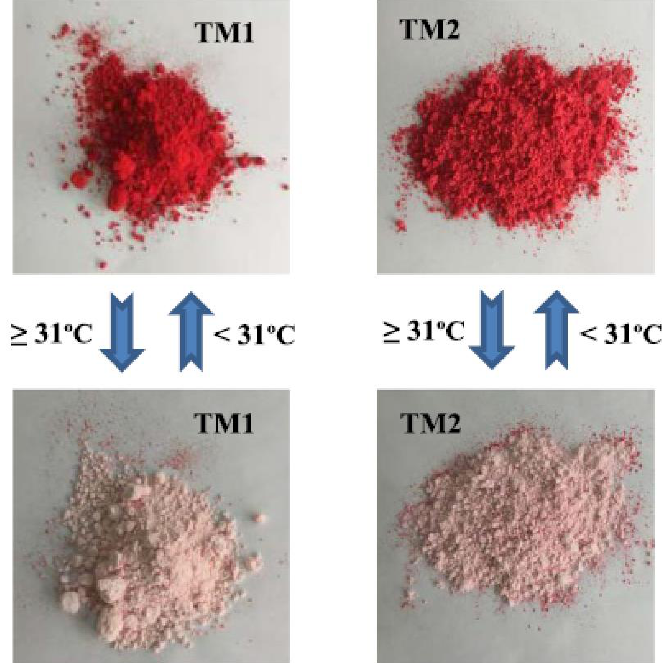
Figure 2. Thermochromic material used as additive to mitigate the heat island effect for pavement